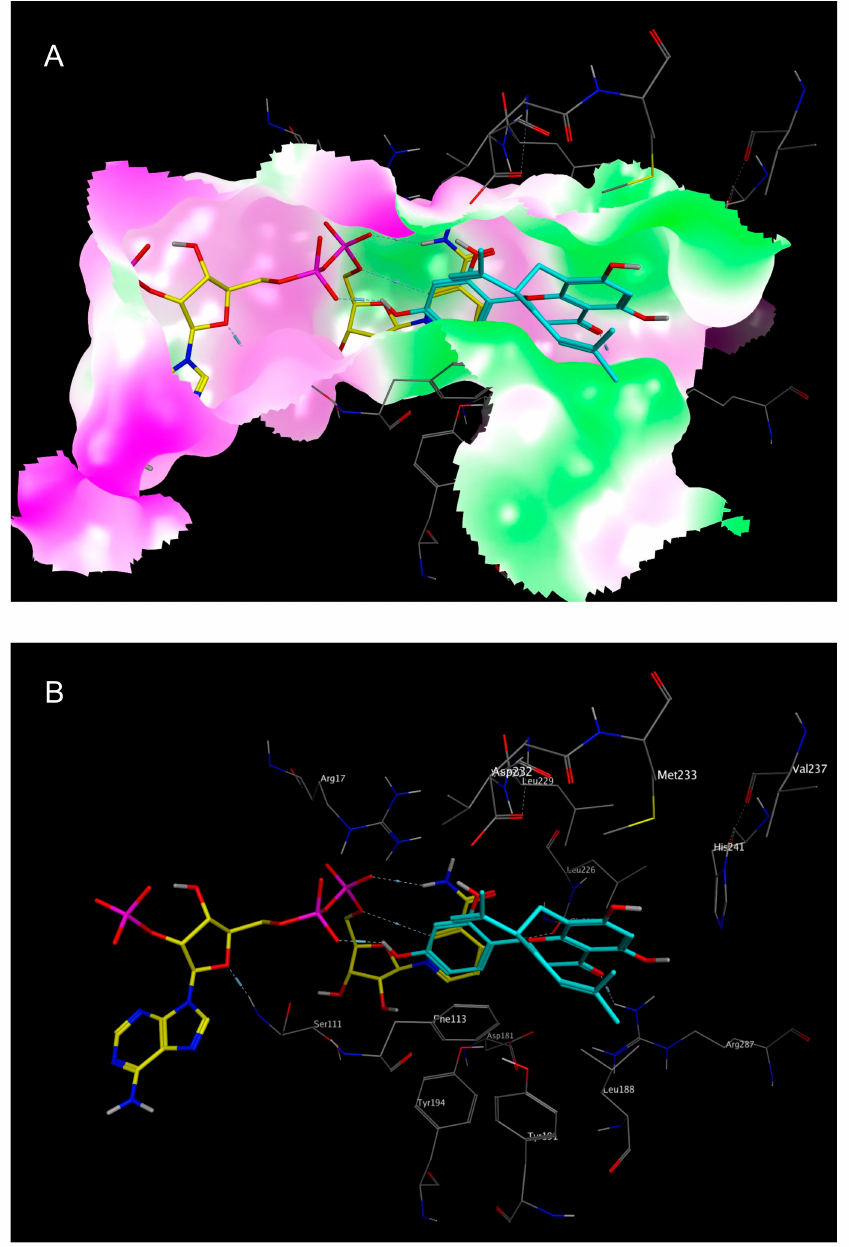
Figure 7. Best calculated docking pose of sophoraflavanone G ( 6 ) in the folic acid binding site of Lm PTR1 (PDB-ID “3H4V”), with the co-crystallized NADP + shown in yellow, and the best docking pose of 6 shown in cyan. ( A ) Rendered surfaces are colored according to lipophilicity, with green indicating high lipophilicity, and purple indicating low lipophilicity; ( B ) Surface not shown, but amino acid residues